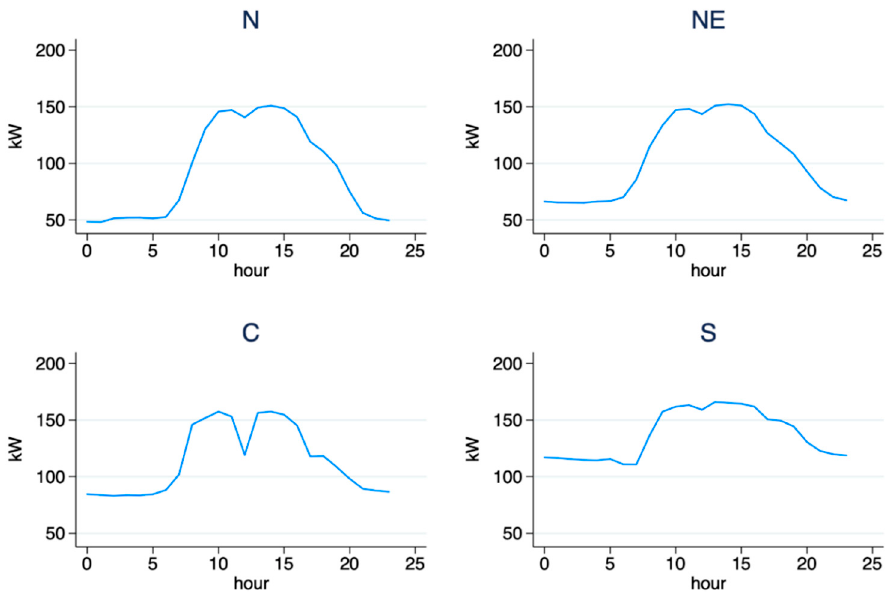
Figure A3. Hourly average load profile of MGS customers in Northern region (N), Northeastern region (NE), Central region (C), and Southern region (S).